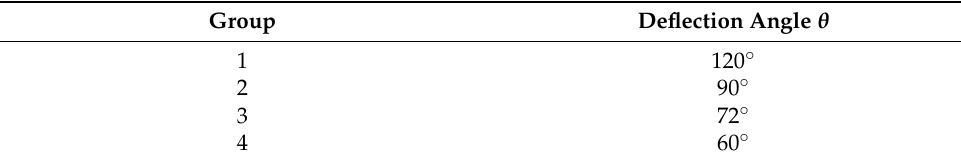
Table 5. Comparison of deflection angle parameter